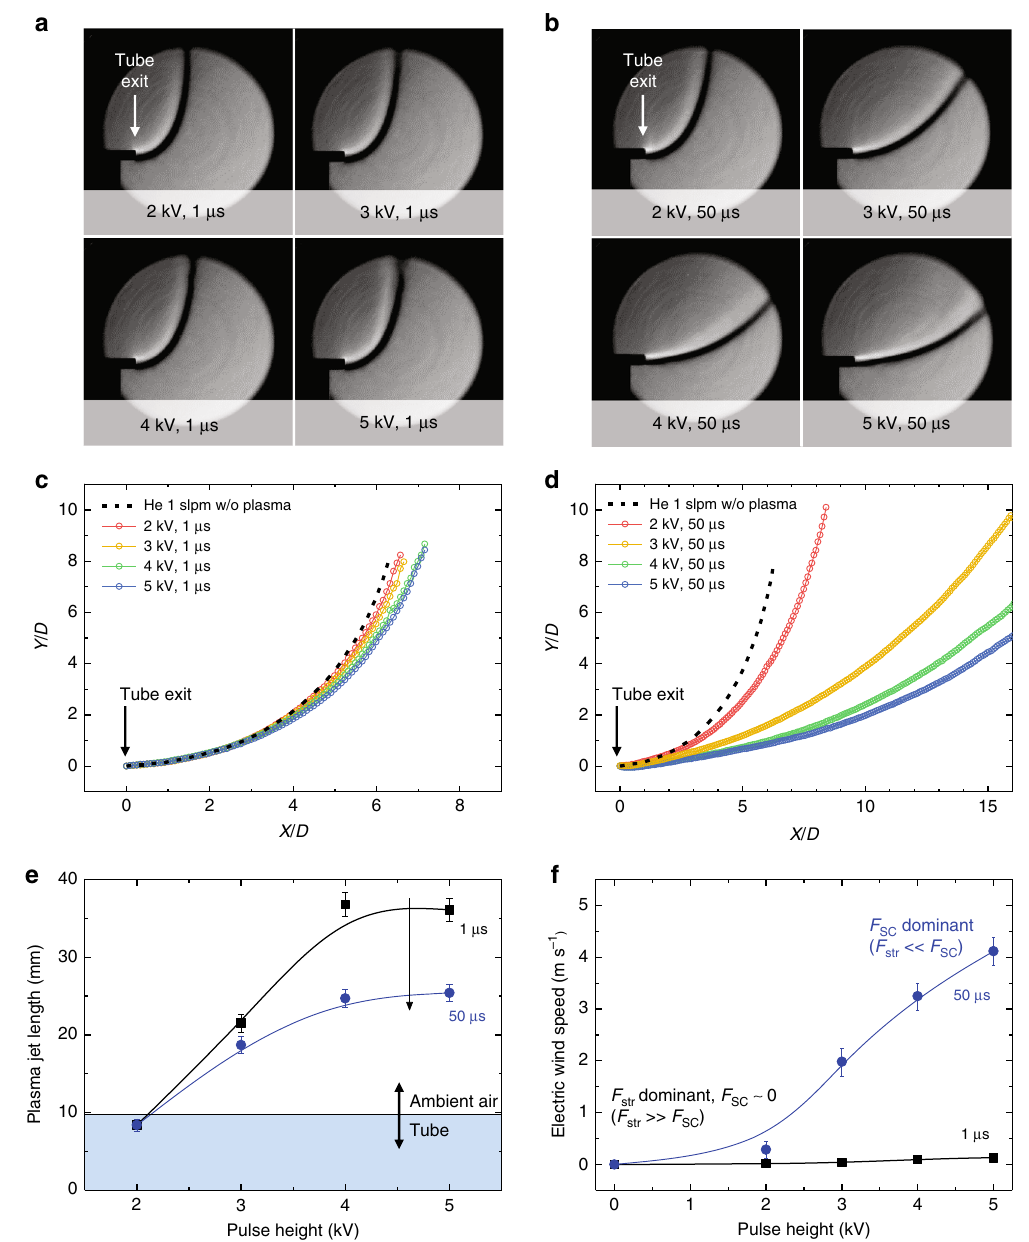
Fig. 3 Variation in the gas fl ow trajectory. Schlieren images of helium fl ow ejected from the plasma jets at different applied voltages with constant pulse widths of a 1 μ s and b 50 μ s and c , d corresponding centerlines of helium fl ow, without plasma (black dashed lines) and in the presence of helium plasma jets generated at different pulse heights. The corresponding e plasma jet total lengths measured over the curvature from the electrode (as detailed in Supplementary Fig. 4) are presented with f the calculated electric wind speeds. The glass tubes with an inner diameter of 3.5 mm are used as substitute for scale bars for all images. Data in e , f are shown as mean ± s.d. for all panels; n =